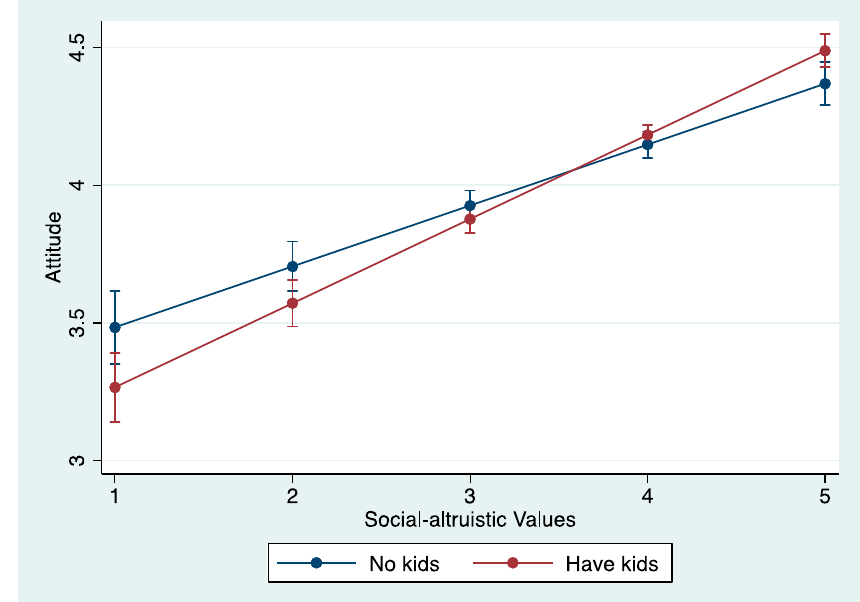
Figure 5. Interaction plot of having children and altruistic values on attitudes.